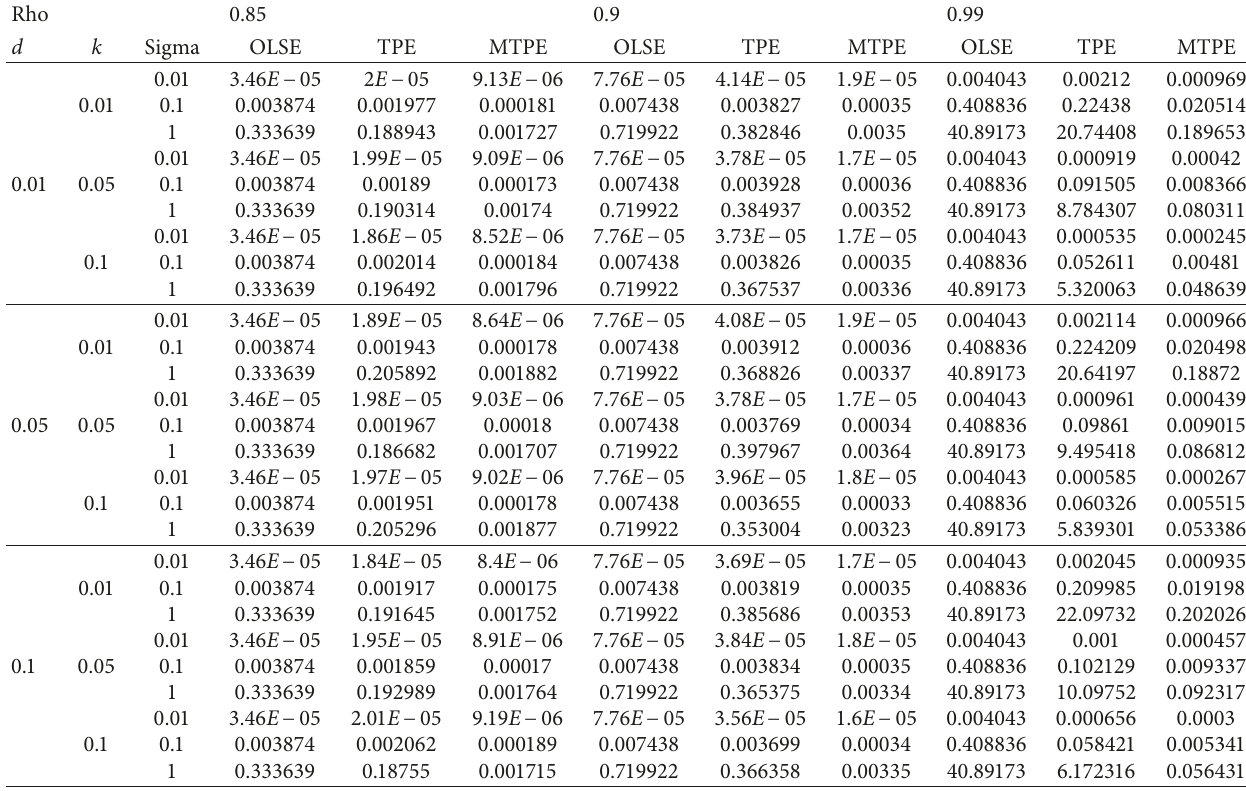
Table 4: Estimated MSE values of the OLSE, TPE, and MTPE when n �